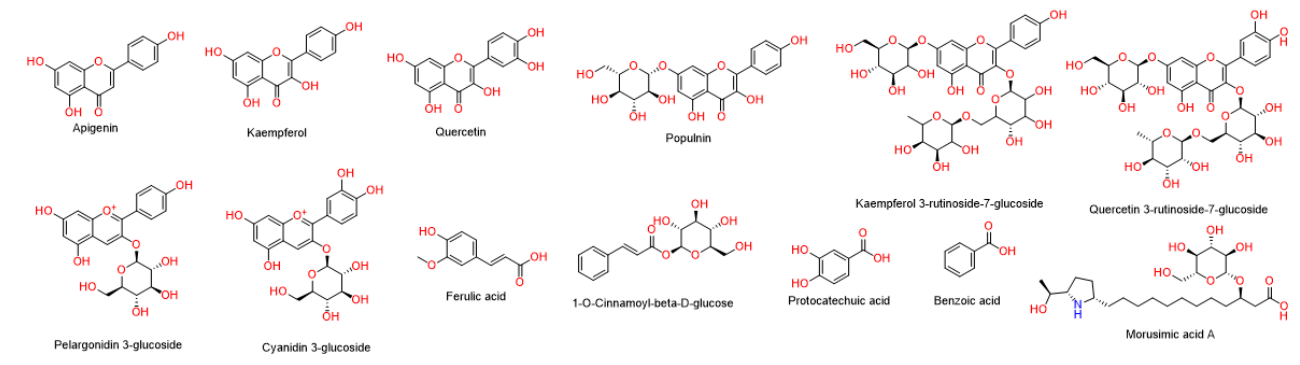
Figure 2. Annotated compounds in BBE .